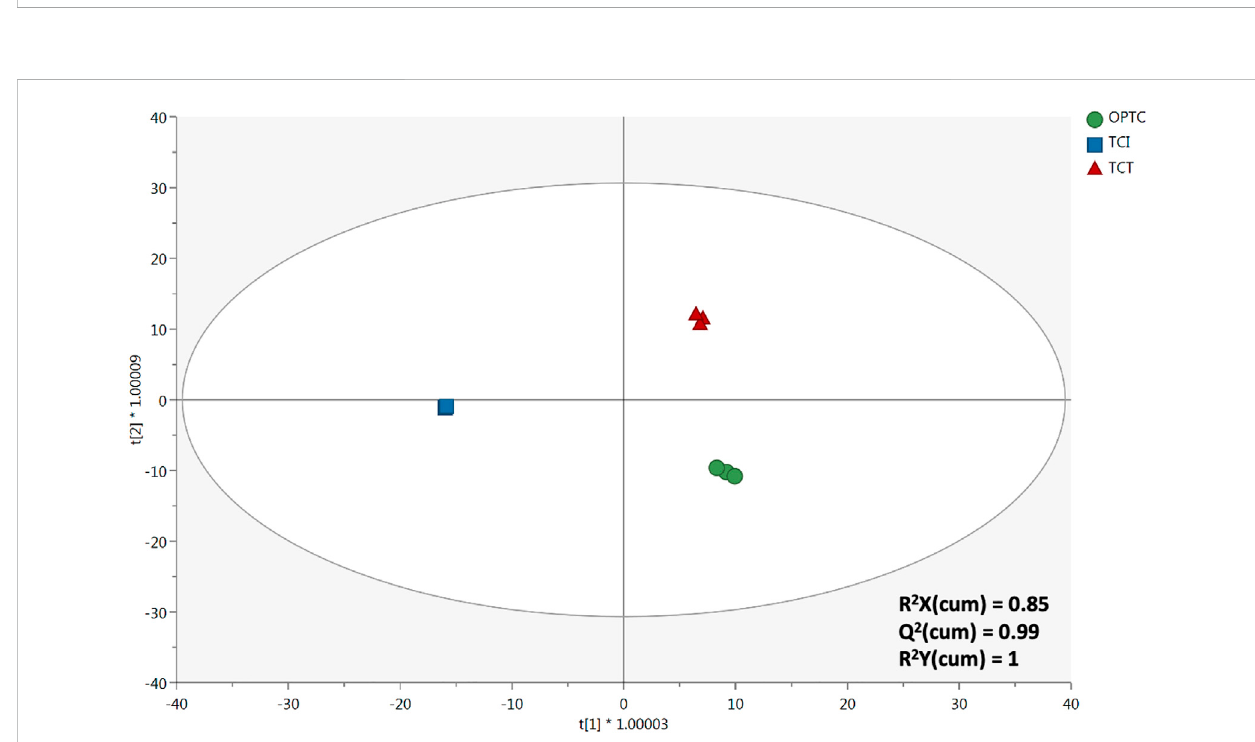
p -coumarate (marker of OpTC and TCI), luteolin 7-galactoside (OpTC and TCI), and malvidin 3-alpha-L-galactoside (marker of TCT). All the VIP marker compounds can be found in supplementary material fi le combined in a detailed list.